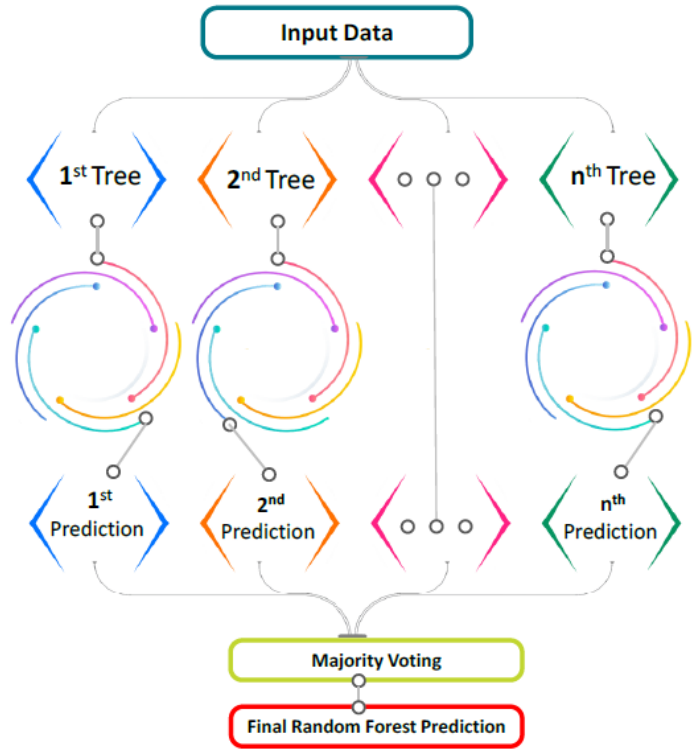
Figure 4. Schematic interpretation of random forest model [80]